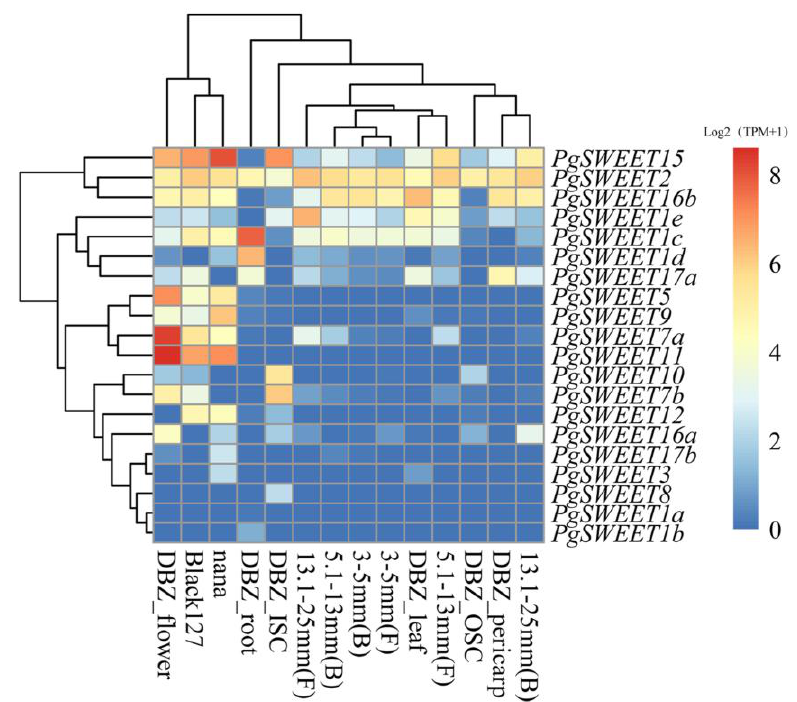
Figure 3. Expression heatmap of SWEET genes in different tissues of pomegranate. Table 3. RNA-seq data of pomegranate.